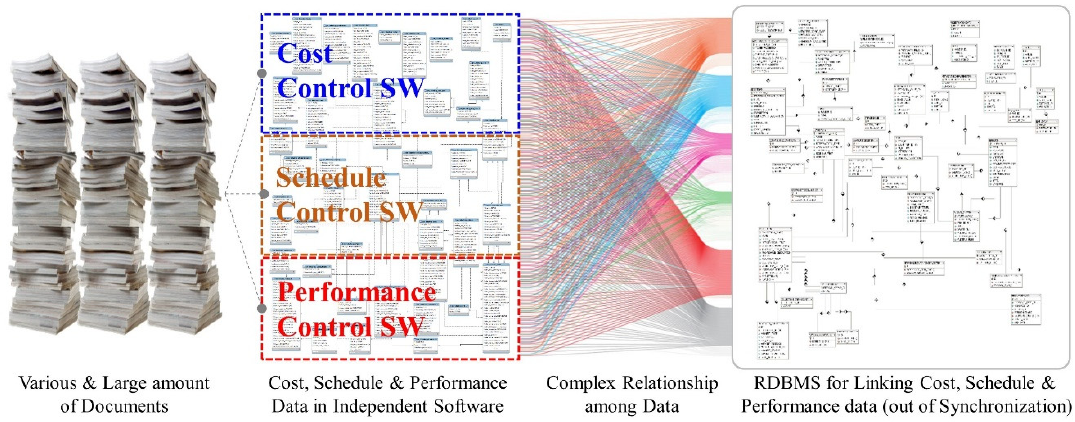
Figure 1. Current Practice of Data Control in Construction Management.